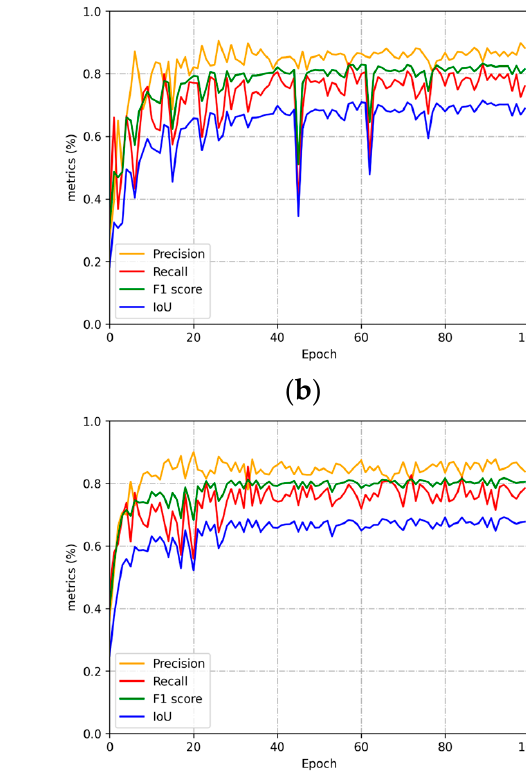
Figure 5. The metrics Precision, Recall, IoU, and F1 score as obtained from Linknet for different backbones: ( a ) vgg16, ( b ) resnet152, ( c ) densenet201, ( d ) inceptionv3.